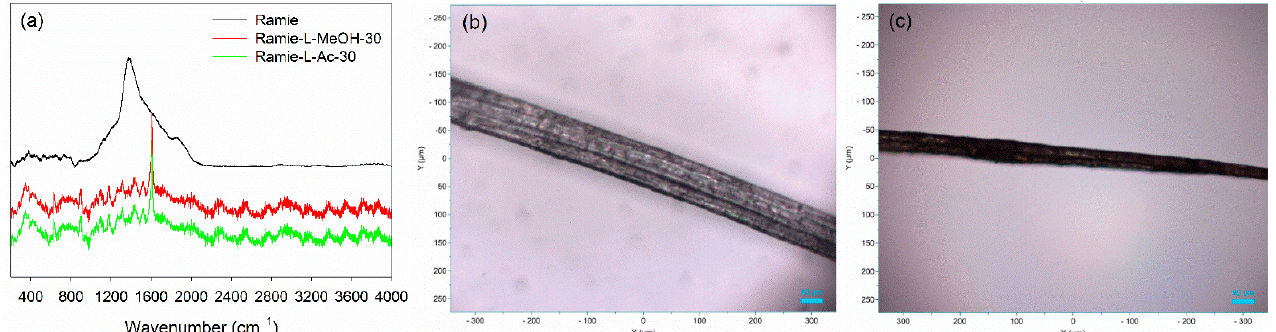
Figure 12. Micro Confocal Raman analysis of ramie fiber: ( a ) Typical Raman spectra of ramie fiber, ( b ) image of ramie fiber before impregnation at 10× magnification, and ( c ) image of ramie fiber after impregnation at 10× magnification.